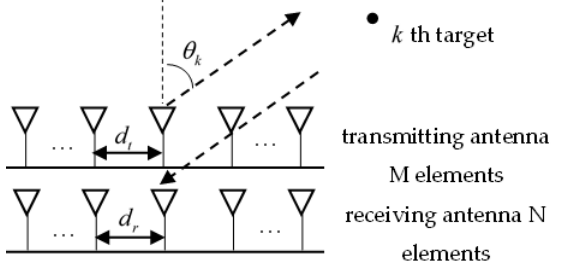
Figure 1. The structure of a monostatic MIMO radar.